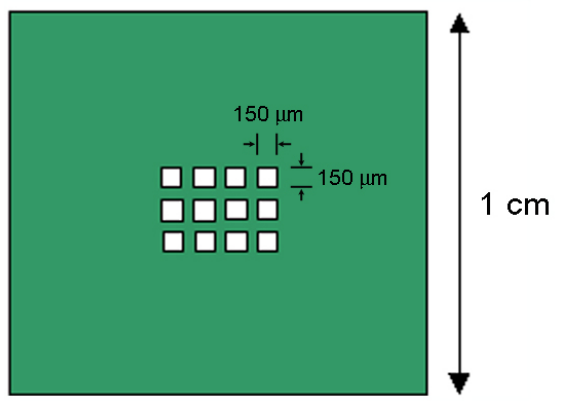
substrate covered by PMMA (middle 2 substrate (bottom curve). Shown in (A), (B) and 2